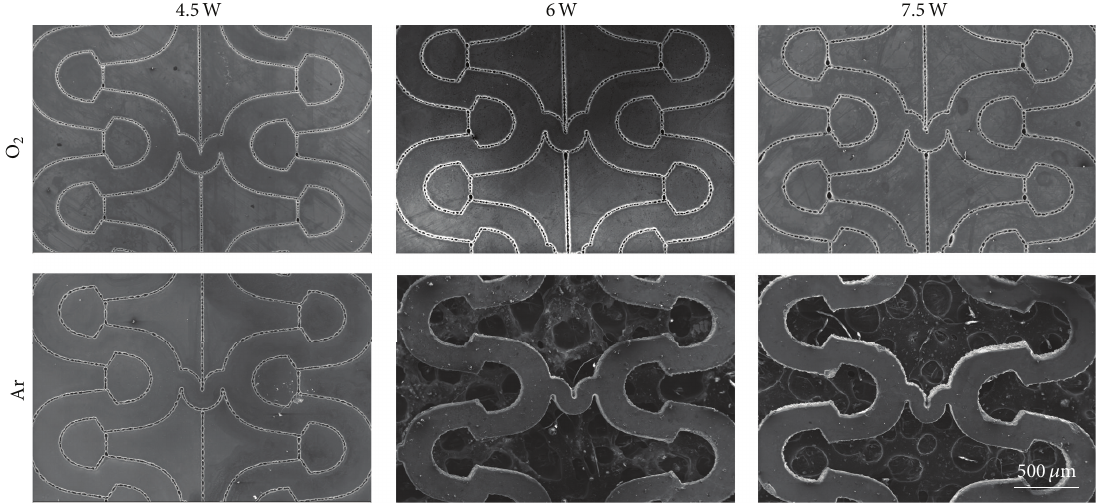
Figure 3: Laser cutting of stent mesh with different power and process gas conditions on flat AZ31. Samples show results after chemical etching. The non-separated specimens were etched until the sheet thickness was reduced to